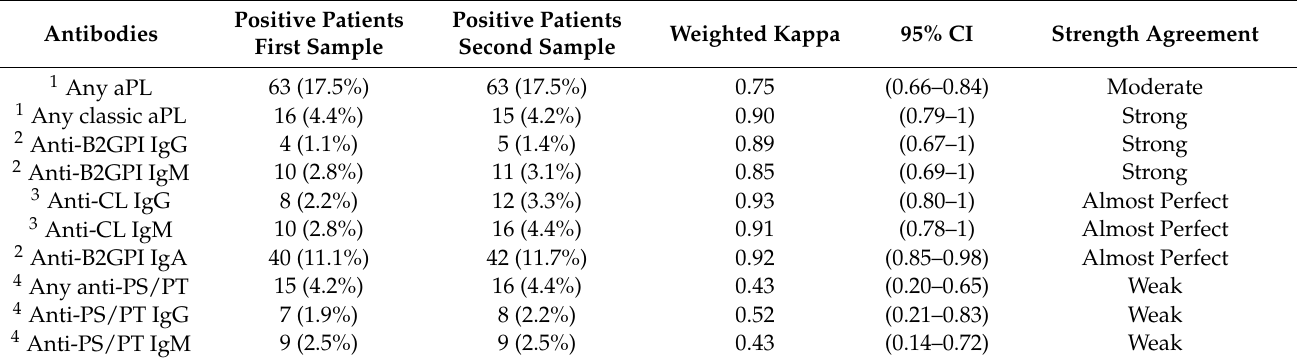
Figure 1. Prevalence of antibodies in first (Light blue) and second serum samples (dark blue). ( a ). Antiphospholipid antibodies. ( b ). Anti-SARS-CoV-2 antibodies. Classic aPL: Anti-Cardiolipin or anti-B2GPI (aB2GPI) of isotypes IgG/M. Anti-B2GPI IgA (aB2GPI IgA), anti-PS/PT (aPS/PT): Anti-phosphatidylserine/prothrombin antibodies of IgG/M isotypes. Table 3. Analysis of the agreement between the evaluations of aPL in the first and second samples. Strength of Agreement was rated according McHugh recommendations